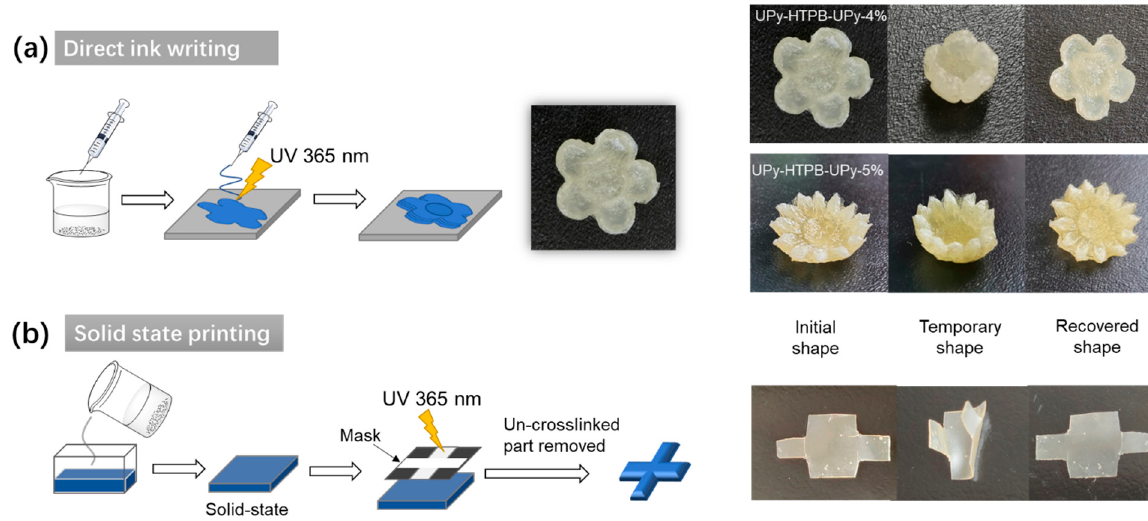
Figure 7. Applications in additive manufacturing: ( a ) DIW and ( b ) solid-state VAM.